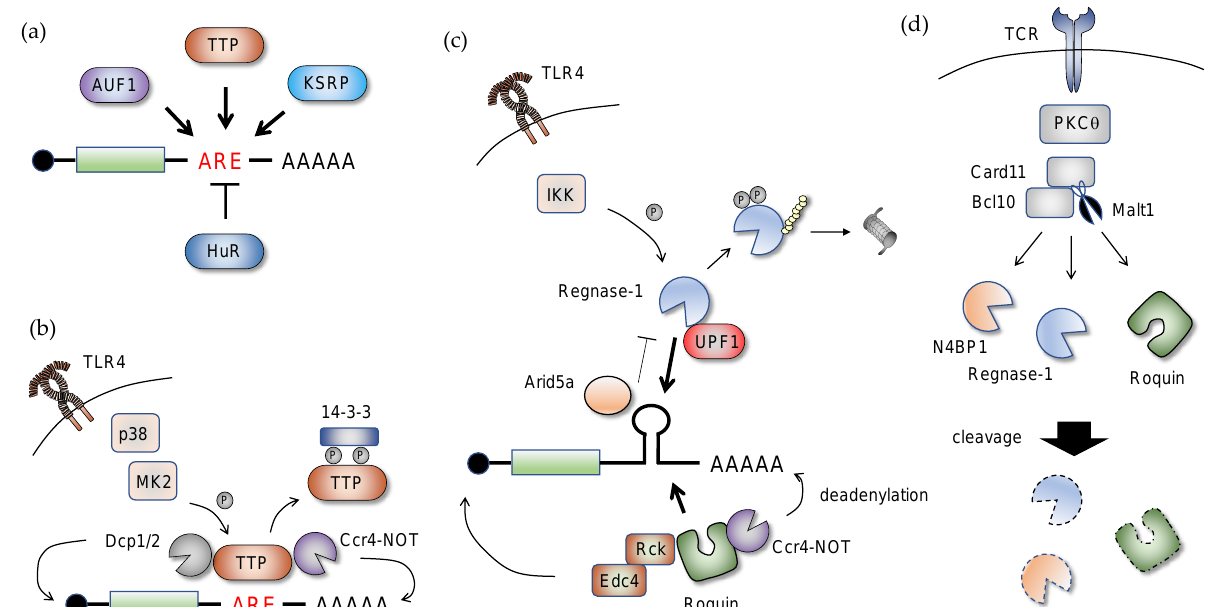
Figure 4. Post-transcriptional mechanisms by RBPs regulating mRNA stability. Figure 4. Posttranscriptional mechanisms by RNA-binding proteins (RBPs) regulating mRNA stability. ( a ) TTP, AUF1, and KSRP are representative RBPs that